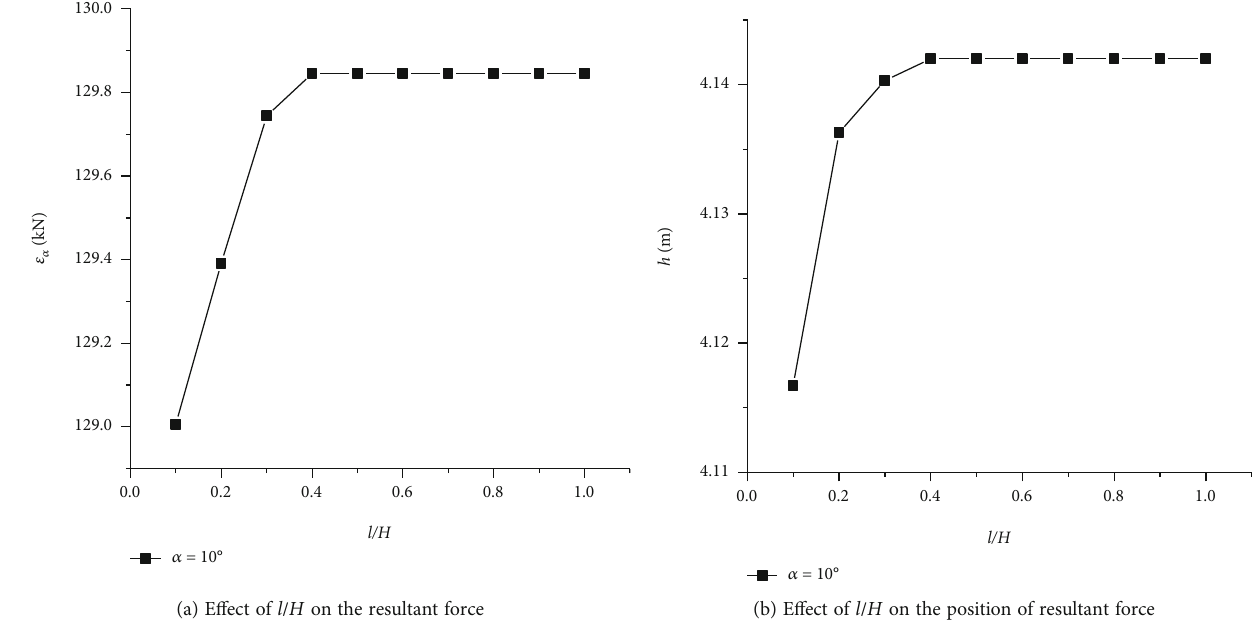
Figure 10: E ff ect of l / H on active earth